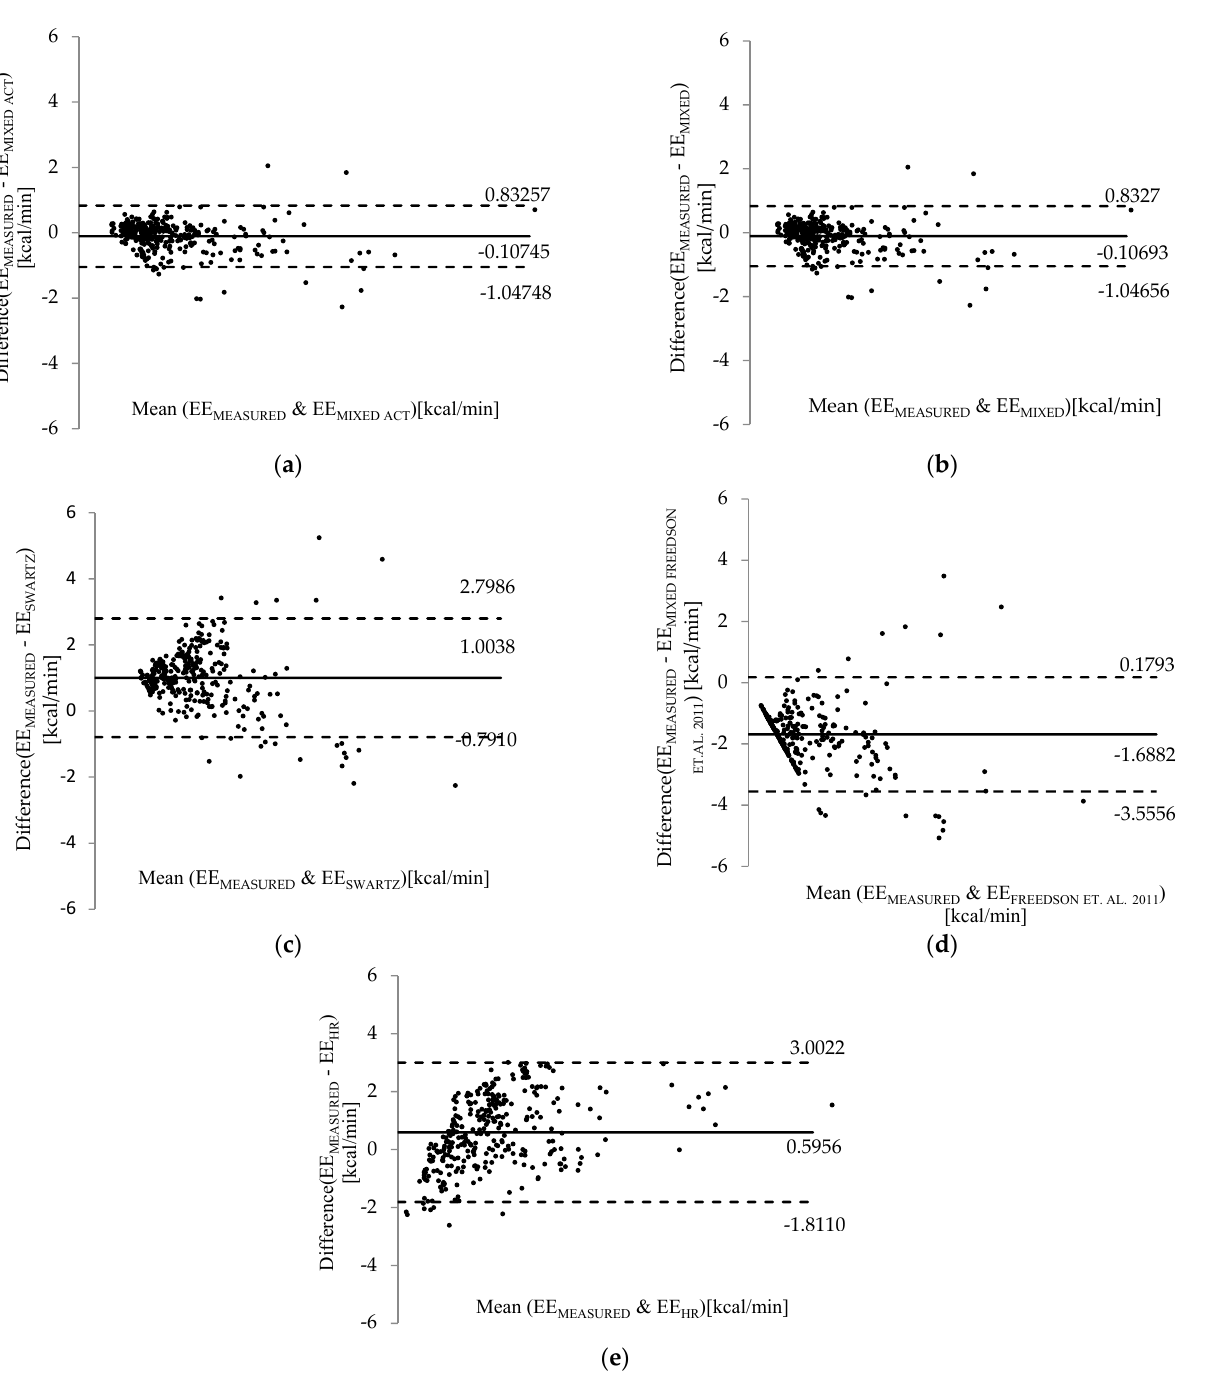
Figure 2. Bland–Altman plot of agreement between measured data and ( a ) the hierarchical mixed model with activity variable, ( b ) the hierarchical mixed model without physical activity level variable, ( c ) the Swartz equation (2000) ( d ) Freedson’s VM3 combined equation (2011), and ( e ) the heart rate relation method ISO 8996:2004.